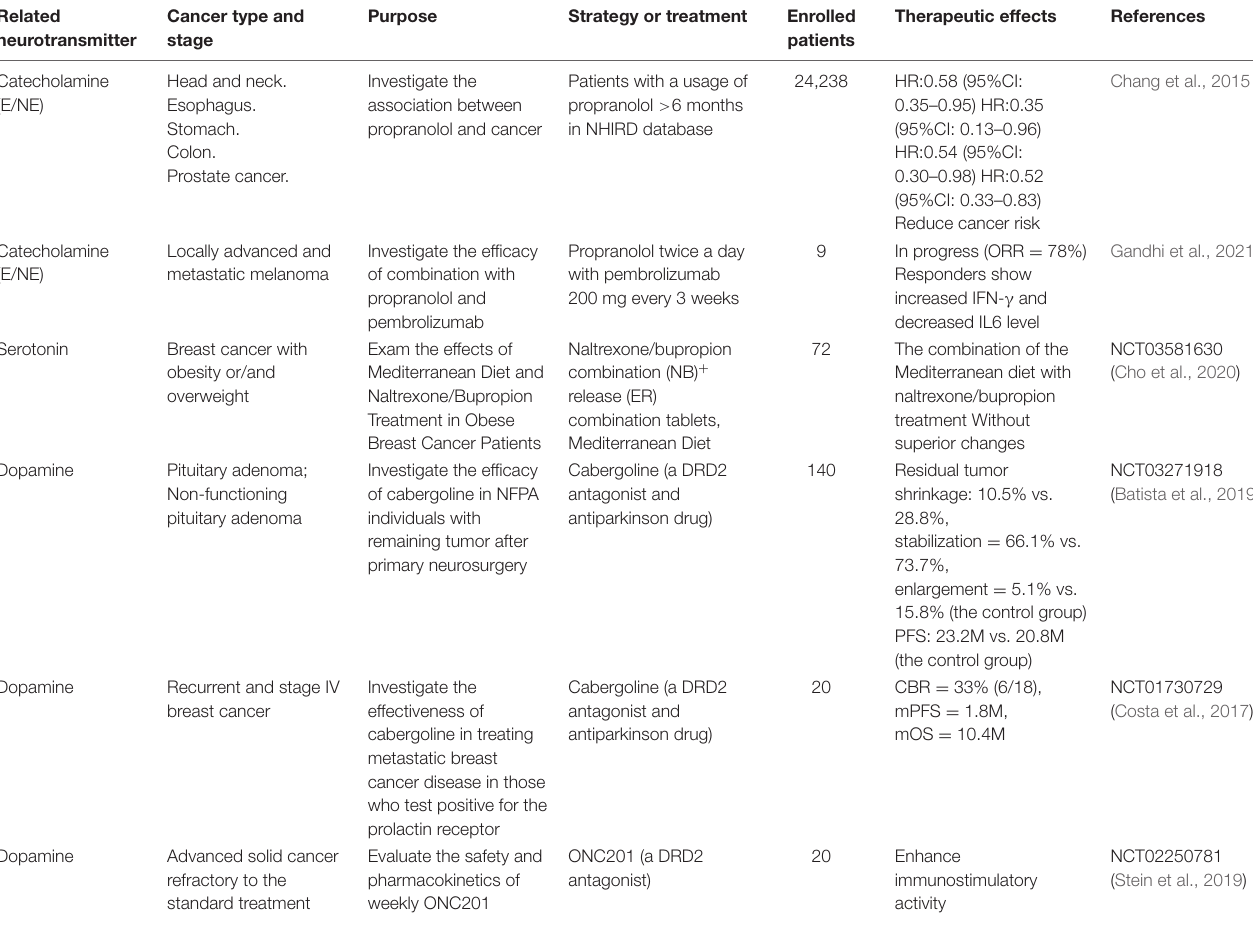
TABLE 4 | Clinical trials related to neurotransmitters in